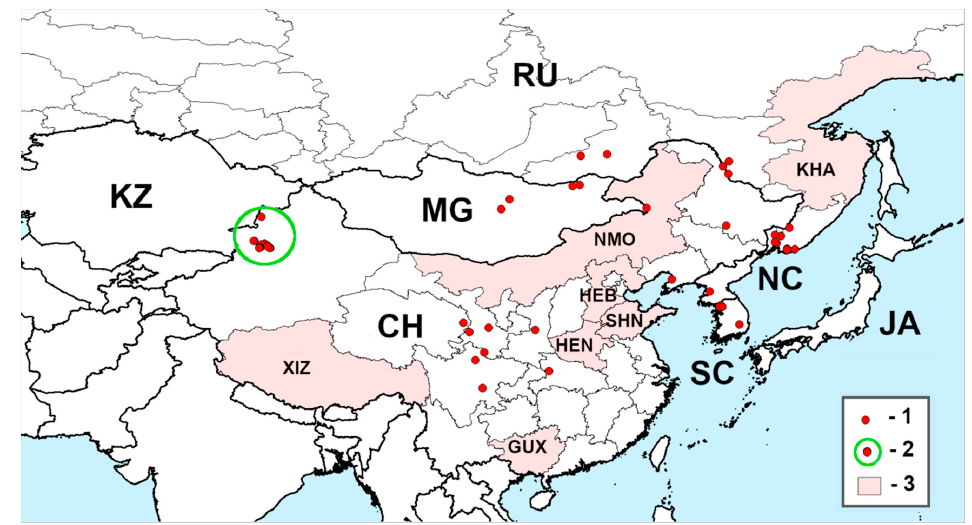
Figure 2. Range of Agrilus mali Matsumura, 1924. 1—documented localities, 2—outbreak sites of Malus sieversii in Xinjiang Uyghur autonomous region, 3—reported administrative units for which exact